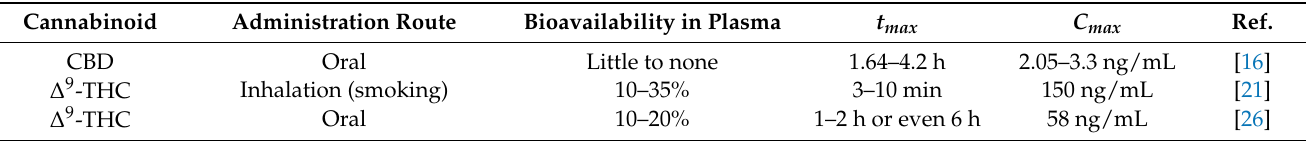
Table 1. The pharmacokinetic parameters of CBD and ∆ 9